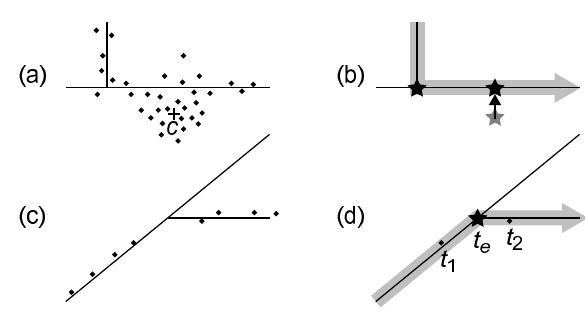
Figure 4: Handling of time. (a) and (b) illustrate the mapping of place centroids against the network infrastructure. (c) and (d) illustrate the interpolation of timestamps for reference